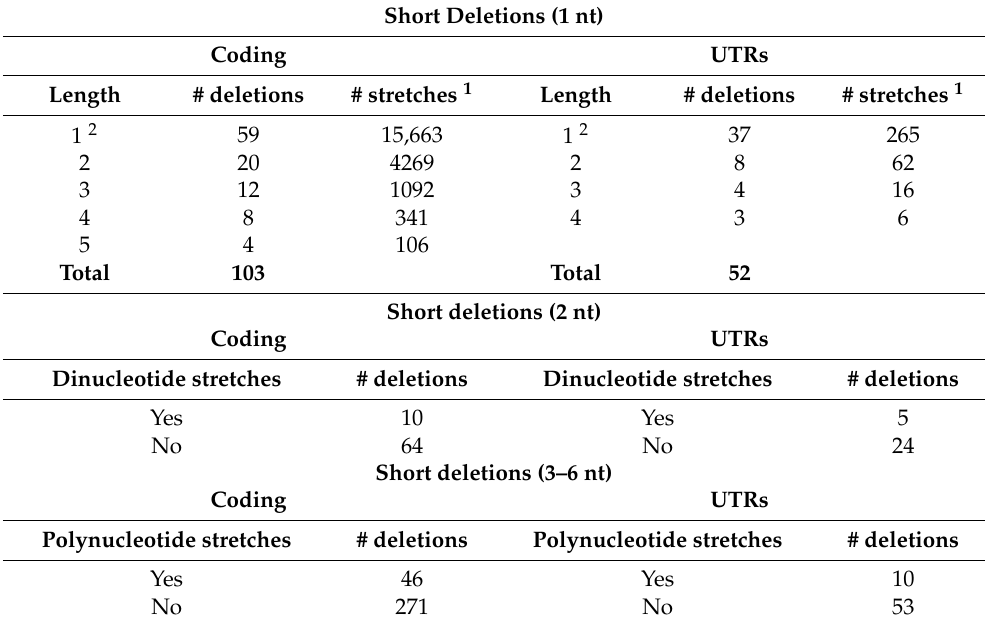
Table 2. Association of short deletion with repetitive elements.